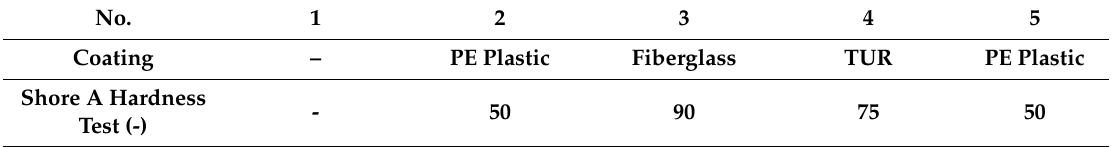
Table 3. Deformation measurement results on beams 270 × 270 × 300